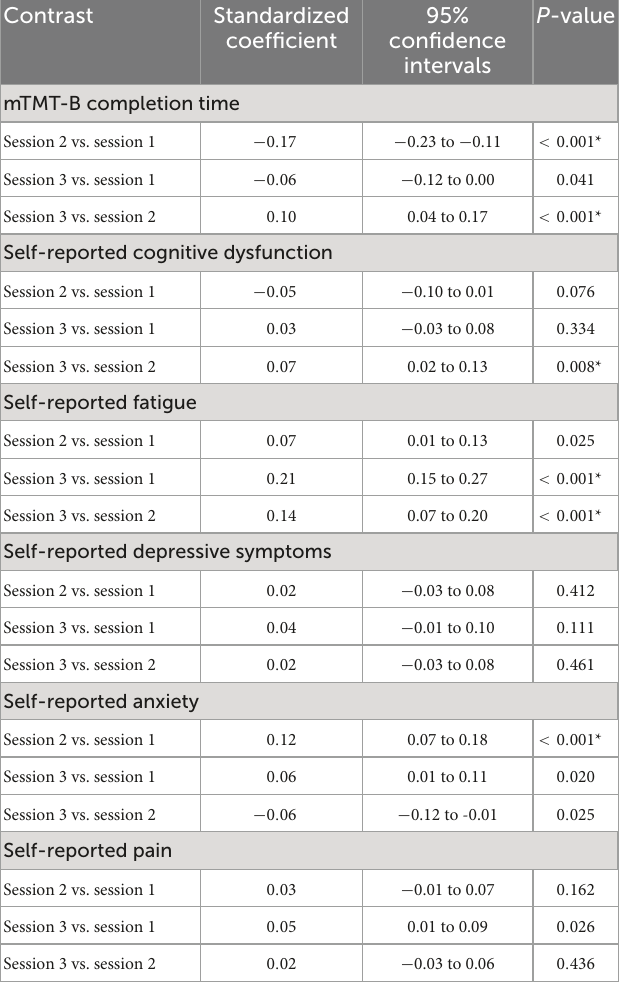
TABLE 4 Model estimates for intra-day symptom fluctuations.